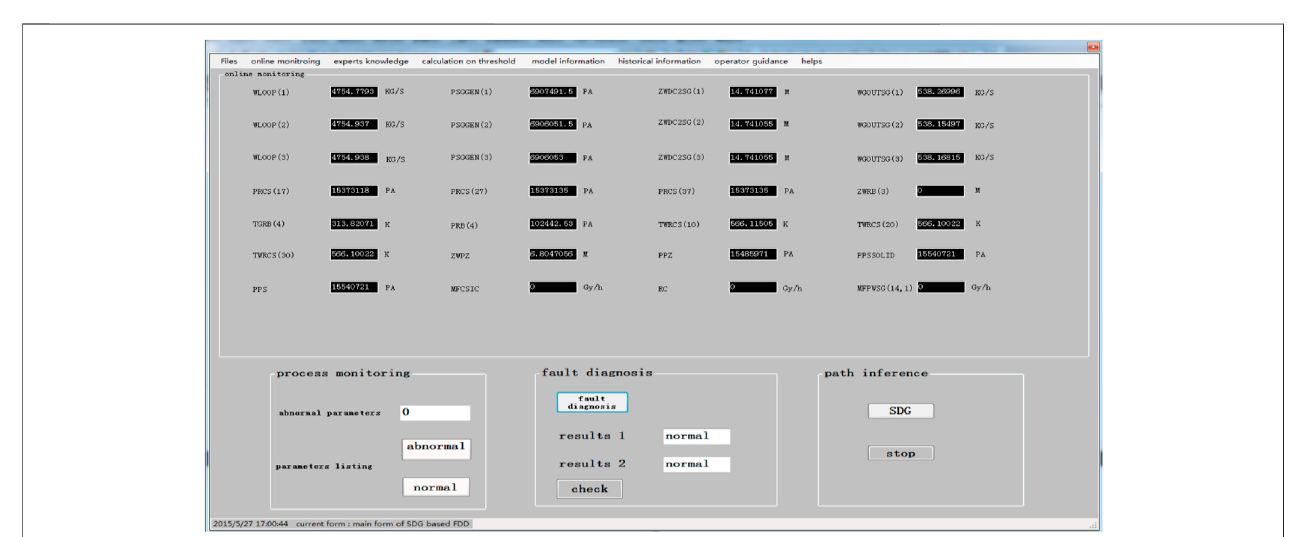
FIGURE 9 | FDD interface in the normal